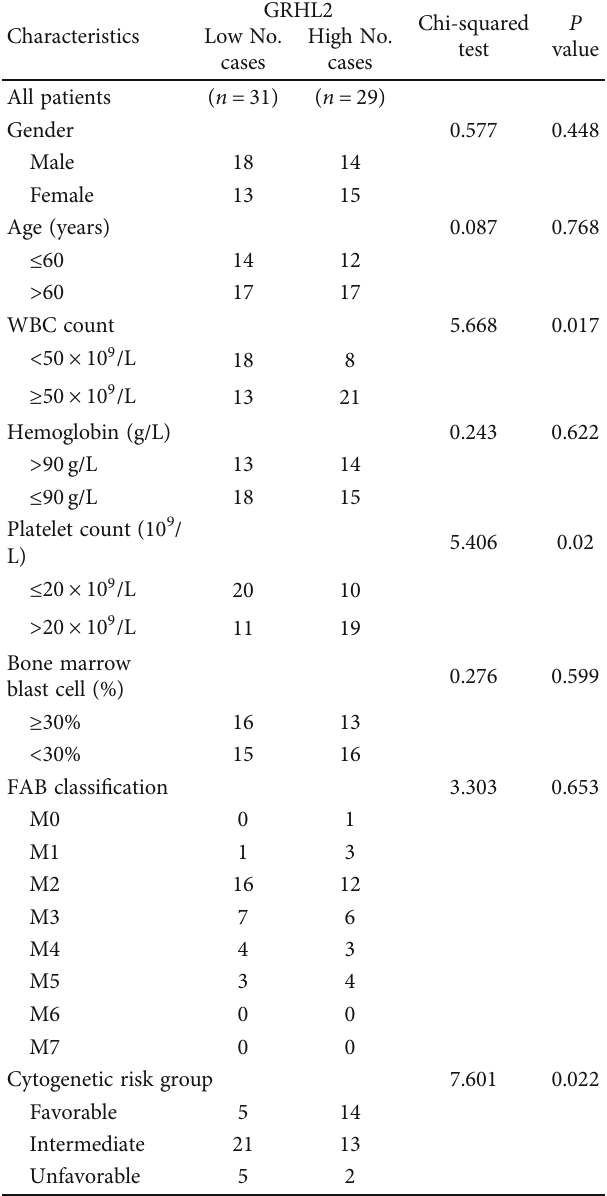
Table 1: The relationship between GRHL2 expression level and clinicopathological features in patients with acute leukemia ( n = 60